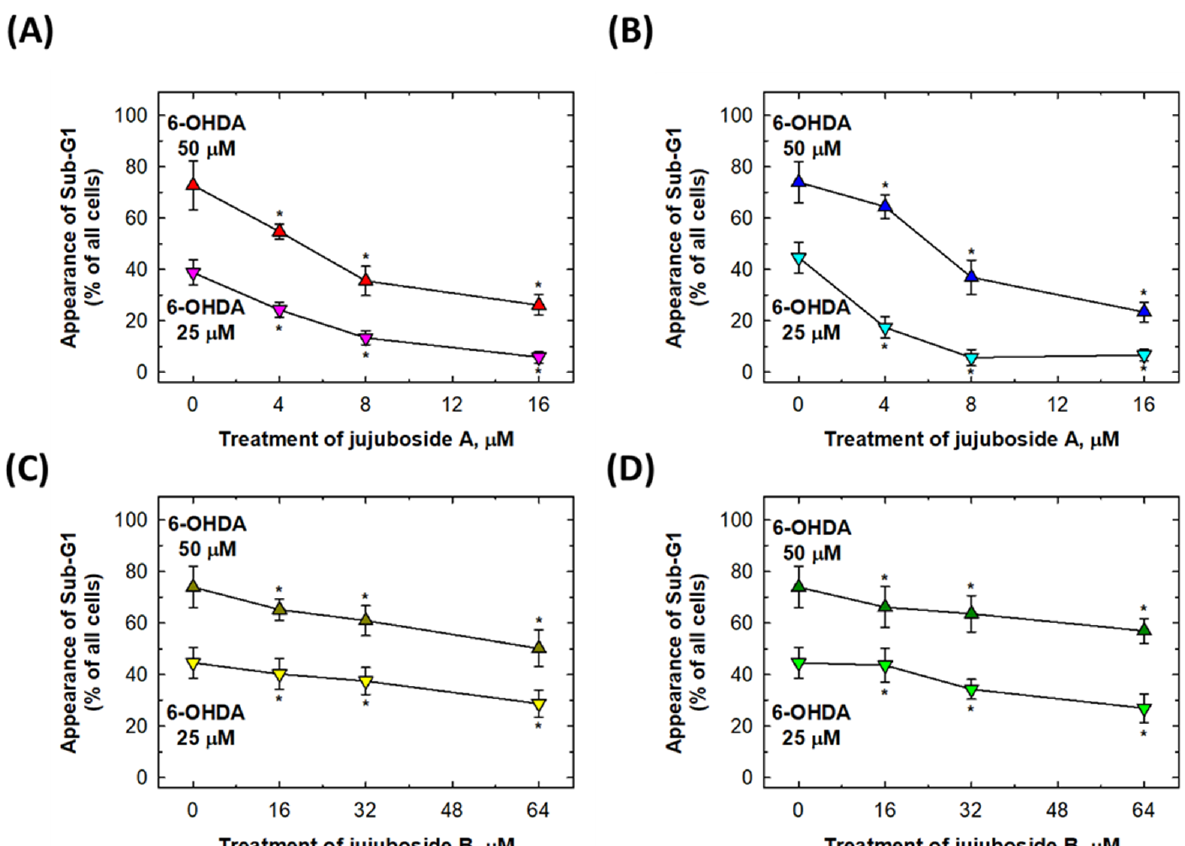
Figure 5. Jujuboside A and B reversed the 6-OHDA-induced cell apoptosis in SH-SY5Y and SK-N-SH cells. ( A , B ) Effects of jujuboside A on SH-SY5Y and SK-N-SH cell apoptosis, respectively. ( C , D ) Effects of jujuboside B on SH-SY5Y and SK-N-SH cell apoptosis, respectively. * Statistically significant from 6-OHDA group. Each experiment was repeated for at least 6 times.